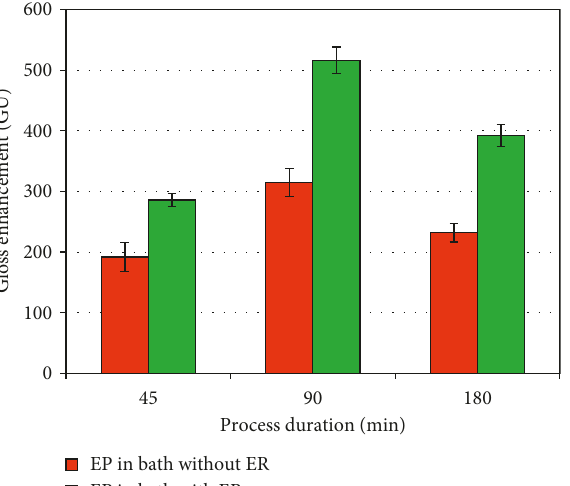
Figure 4: Enhanced gloss after electropolishing in a bath without ER and with ER (EP process parameters: t 2 , q 2.25–9.00Amin i 0.05A cm (cid:31) (cid:31) · −